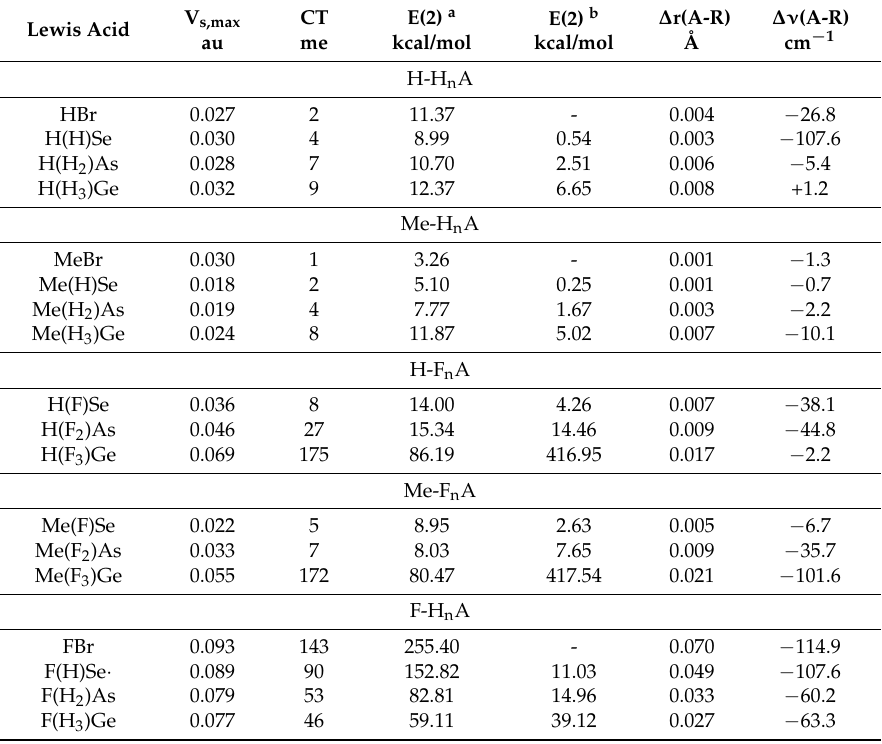
Table 2. MEP maximum (V s,max ) of the σ -hole of the acid monomer facing the base, total charge transfer (CT) from the Lewis base to the acid, NBO values of E(2) from the N lone pair of NH 3 to σ *(A-R) antibonding orbitals where A is the central atom of the Lewis acid and R is (a) the atom directly opposite N and (b) the peripheral atom(s). Also shown is change in A-R bond length ( ∆ r) and vibrational frequency ( ∆ ν ) of the A-R stretch, where R lies opposite